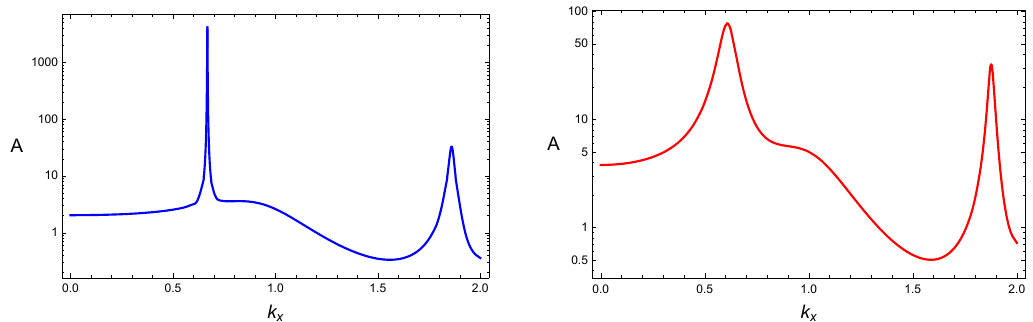
Figure 14 . The MDF along the k x -axis for the amplitude of the ionic lattice a 0 = 0 : 1(left plot) and a 0 = 0 : 8 (right plot) for (cid:12)xed ! = 10 (cid:0) 6 , q = 2 and T = 0 : 019. The (cid:12)rst Brillouin zone boundary is at k x = 2. This shows that the inner Fermi surface dissolves as the strength of the ionic lattice increases. Note that the vertical axis is logarithmic, and that there is a very sharp peak indicative of a Fermi surface. We have chosen L = 1 and (cid:22) = 2 : 35.